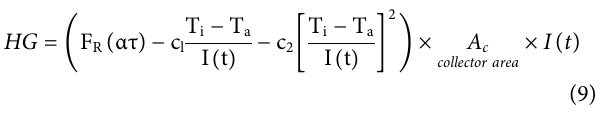
Frontiers in Energy Research |